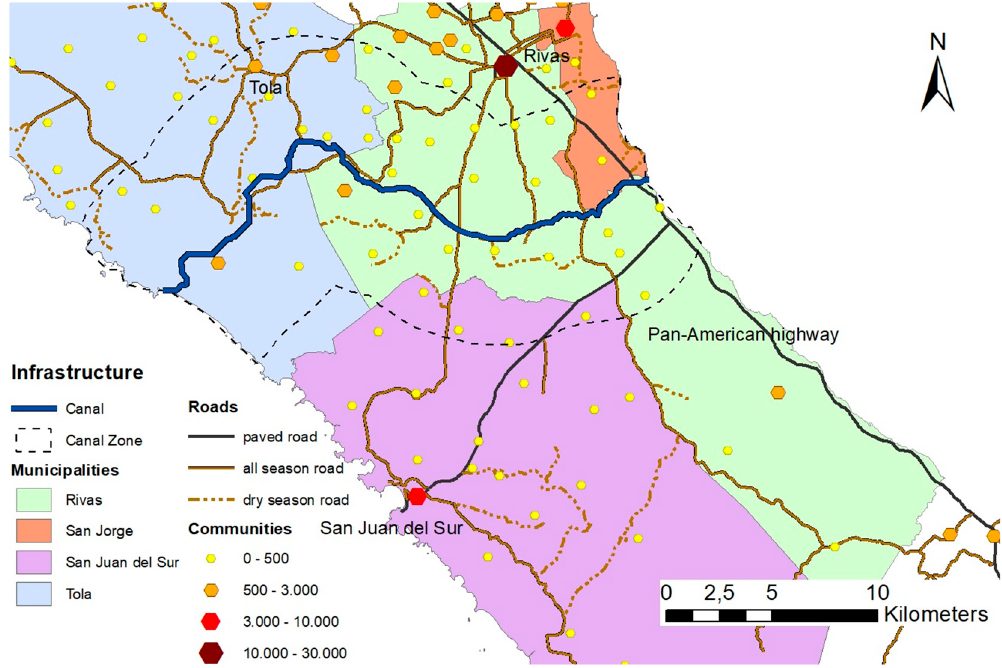
Figure 7. Affected communities and roads due to the canal construction [24].